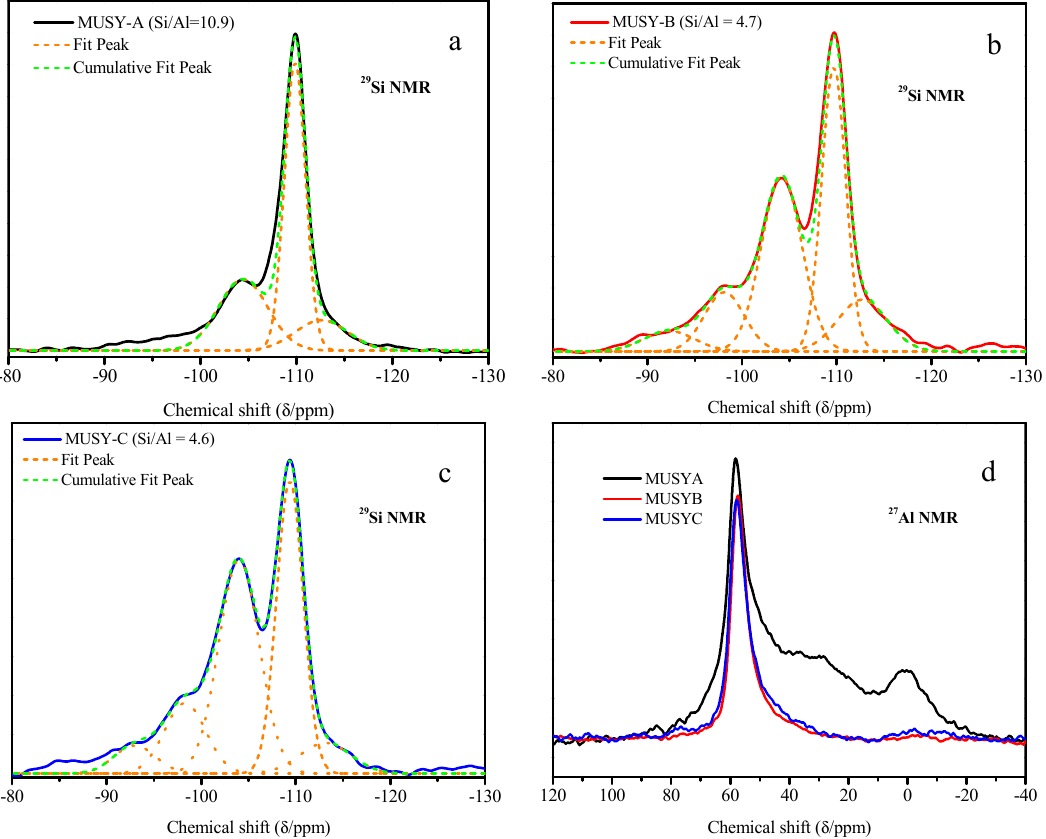
Figure 4. MAS NMR spectra of the zeolite samples. 29 Si NMR spectra of MUSY-A ( a ), -B ( b ) and –C ( c ), 27 Al NMR spectra of the three samples ( d ).